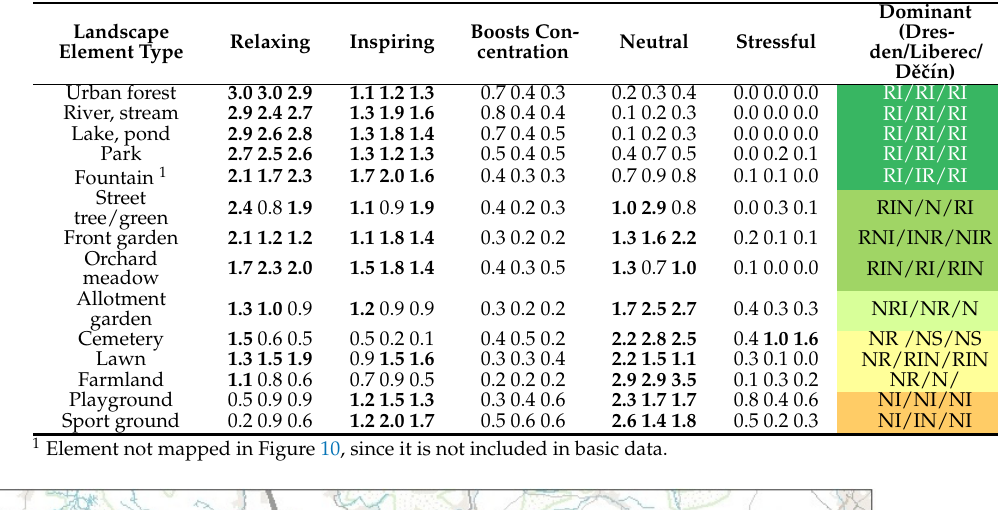
Table 7. Health effects of landscape element types as evaluated by respondents in Dresden (followed by the values for Liberec and Dˇeˇc í n); the figures in bold are the dominant types, the colours in last column refer to the health effects mapped in Figure 10.